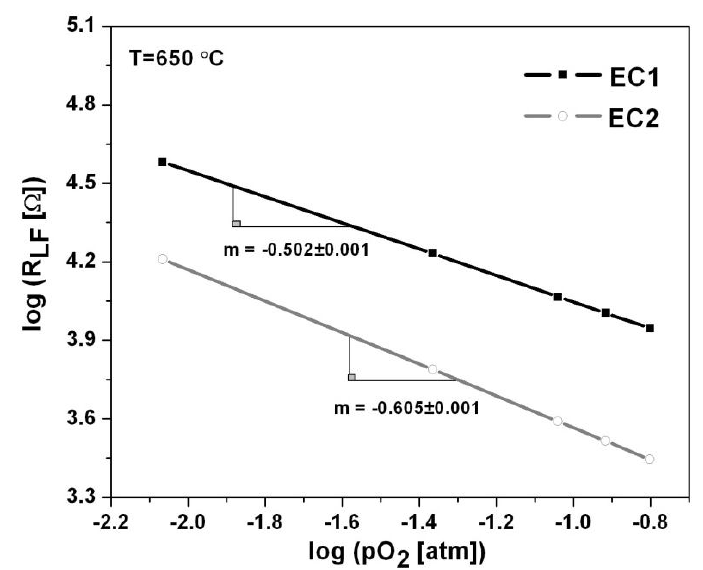
Figure 6. The oxygen partial pressure dependence of the EC1 and EC2 sensors is shown for data collected at 650 °C for oxygen concentrations ranging from 1% to 18%.